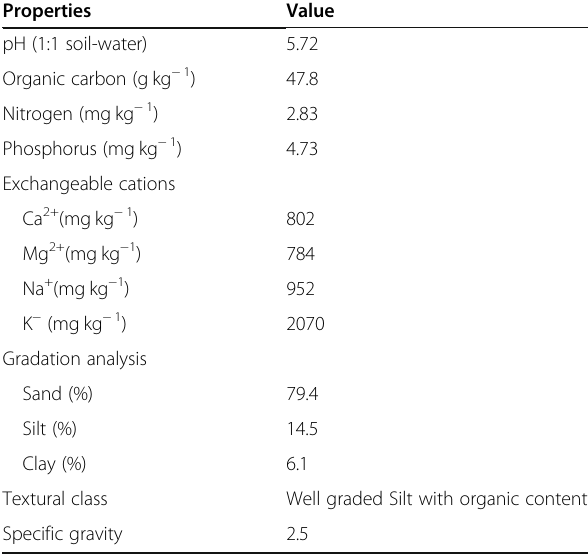
Table 1 Physical and chemical properties of the soil used